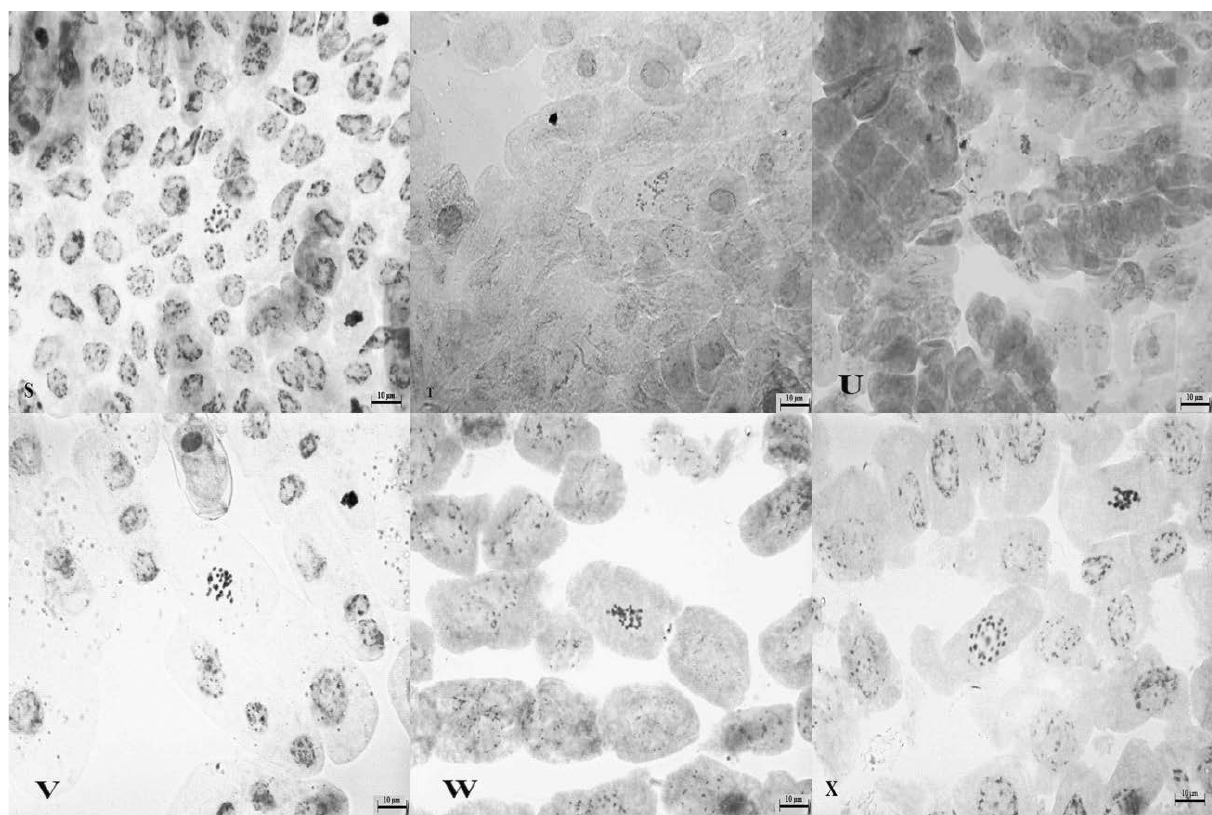
Figure 1S-X. Somatic metaphase chromosomes of Origanum taxa: S) O . syriacum subsp. bevanii (TD4336); T) O . vulgare subsp. gracile (TD4821); U) O . vulgare subsp. hirtum (TD4507); V) O . vulgare subsp. viridulum (TD4662a); W) O . vulgare subsp. vulgare (TD4688); X) O. laevigatum (TD4497). Scale bar: 10